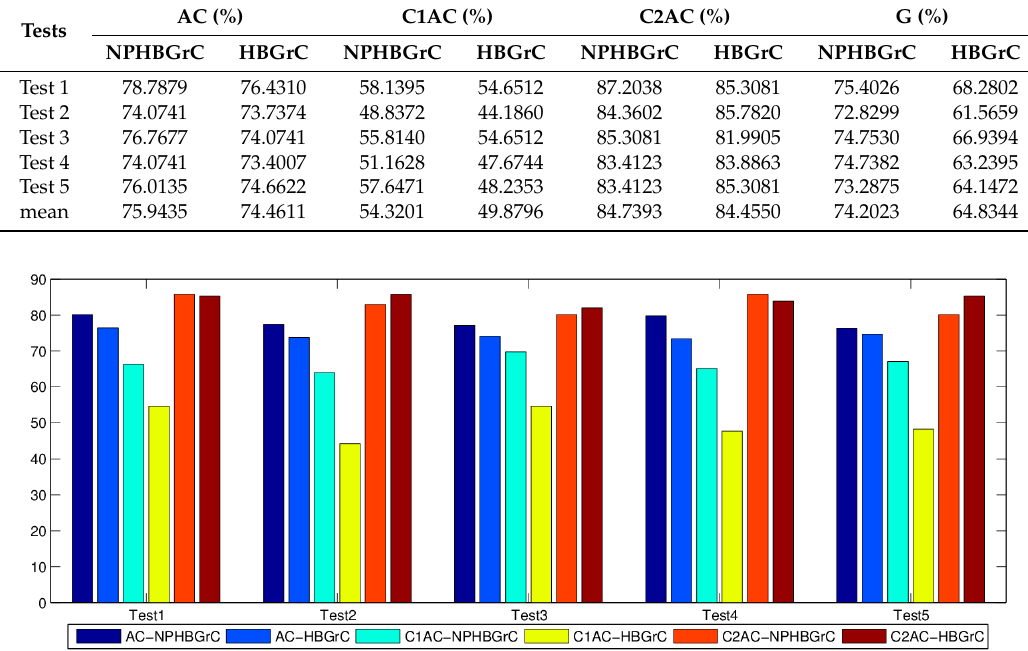
Figure 6. The histogram of performance by nonparametric hyperbox granular computing classification algorithm (NPHBGrC) and HBGrC for the yeast dataset.